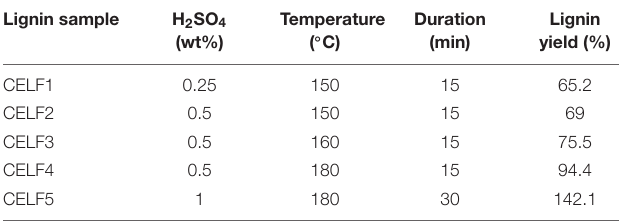
TABLE 1 | CELF pretreatment conditions and mass yield (%) of CELF lignin in total poplar